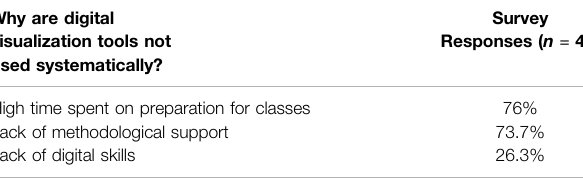
TABLE 1 | Survey responses (Asta fi eva et al., 2020). Why are digital visualization tools not used